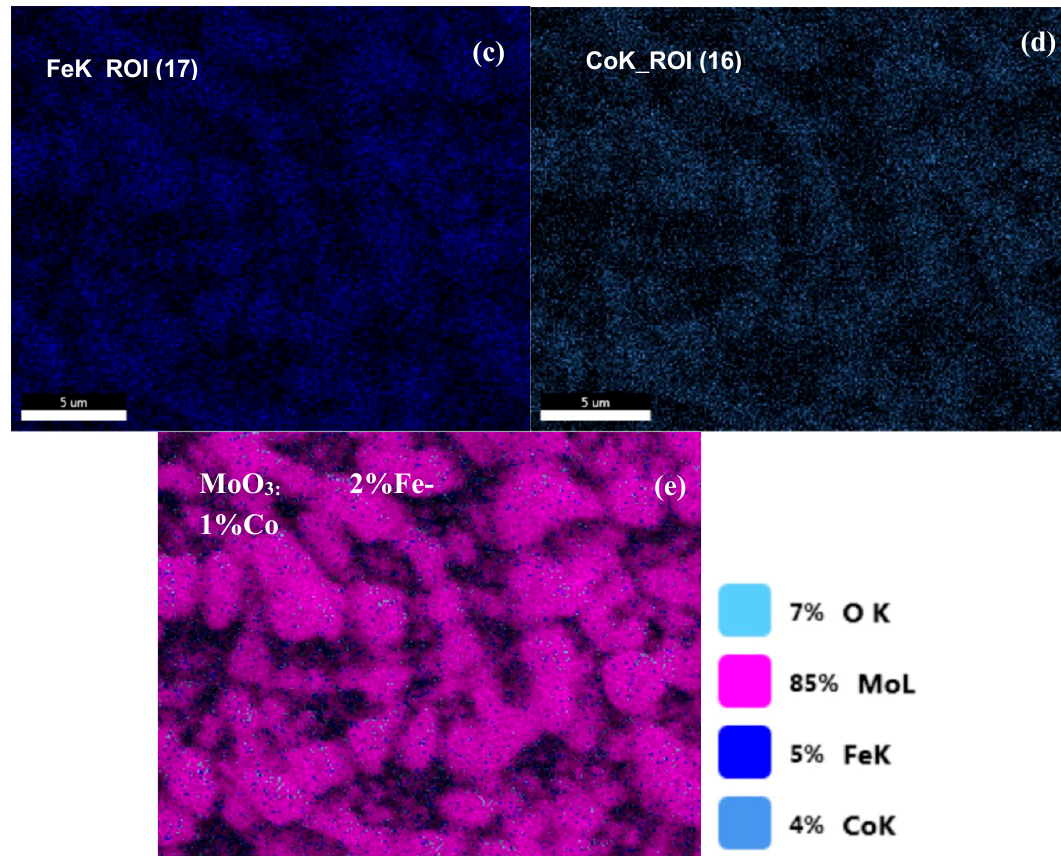
Figure 3. Scanning electron microscopy (SEM) elemental mapping of the MoO 3 surface; ( a ) pink color shows molybdenum atoms; ( b ) light blue color shows oxygen atoms; ( c ) navy blue color represents Fe present on the surface, ( d ) grey color shows the Co atoms and ( e ) MoO 3 surface mapping showing the distribution of all the elements on the surface. Table 4. Characteristic energy lines for oxygen and molybdenum.